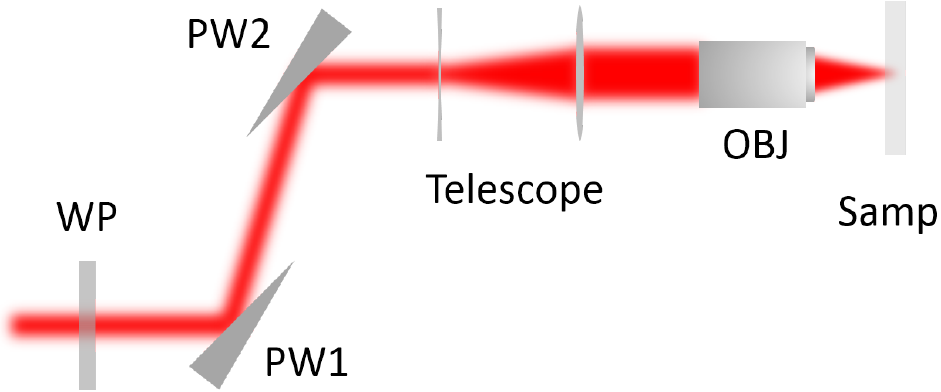
Figure 1. Schematic of the experimental setup. WP: λ /2 plate; PW1, PW2: prism wedge; Telescope: telescope beam expander; OBJ: microscope